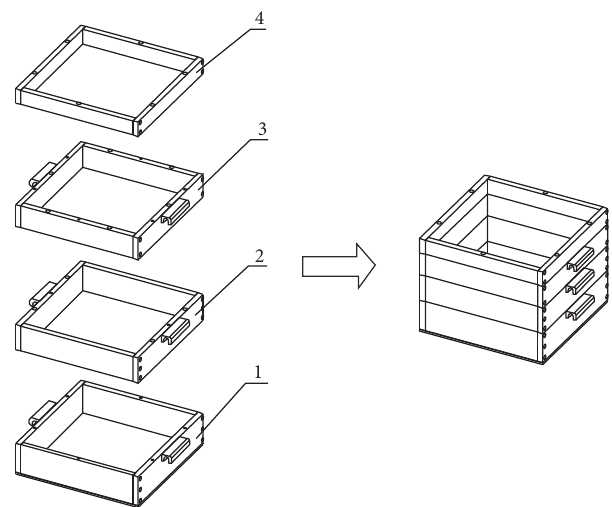
Figure 1: Schematic diagram of the developed full-depth wheel tracking test